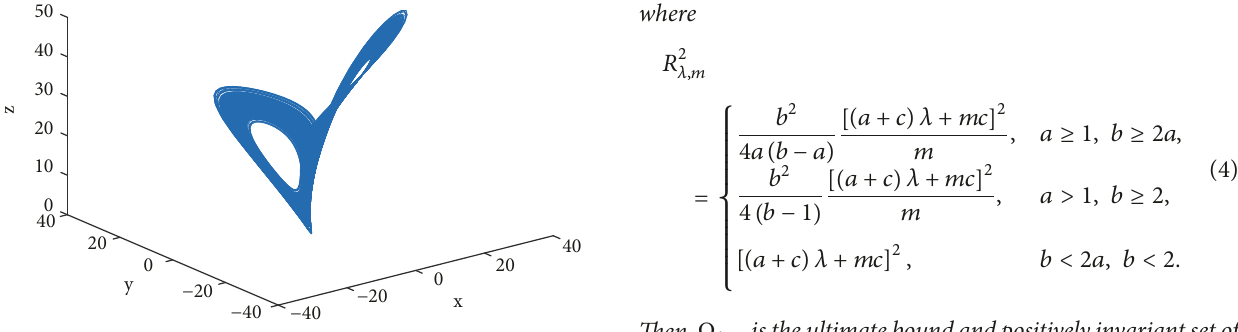
Figure 1: Chaotic attractor of system (2) in xOyz space for 𝑎 = 35 , 𝑏 = 7 , and 𝑐 = 25 .